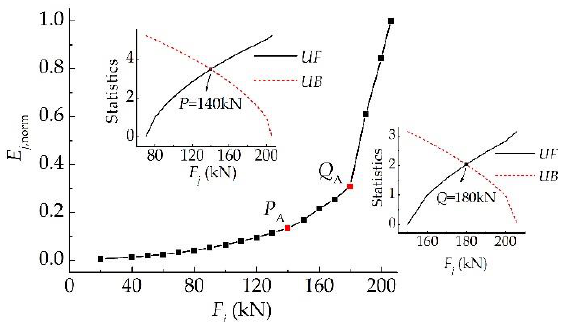
Figure 7. The E-F curve of arch-A and characteristic loads distinguished by Mann-Kendall (M-K) criterion.